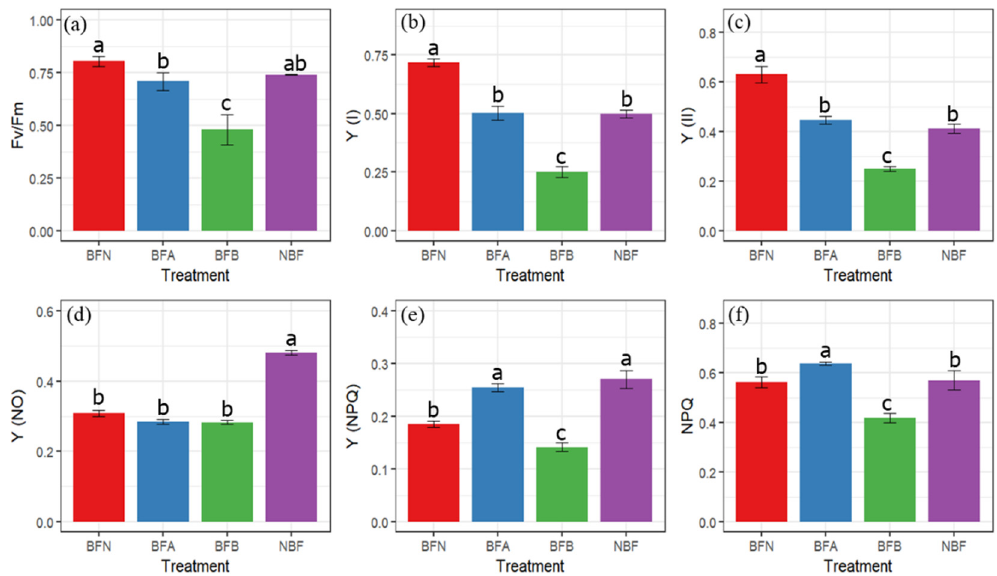
Figure 4. Effects of sunburn on chlorophyll fluorescence parameters. ( a ) F v /F m , ( b ) actual PSI effi- ciency Y (I), ( c ) actual PSI efficiency Y (II), ( d ) the quantum yield of non-regulated energy dissipation of PSII (Y (NO)), ( e ) the quantum yield of regulated energy dissipation of PSII (Y (NPQ)), and ( f ) non-photochemical quenching (NPQ). Vertical bars are the mean ± SE ( n = 3). Different letters above the bars indicate significant differences at the 0.05 level by Duncan’s multiple range test.